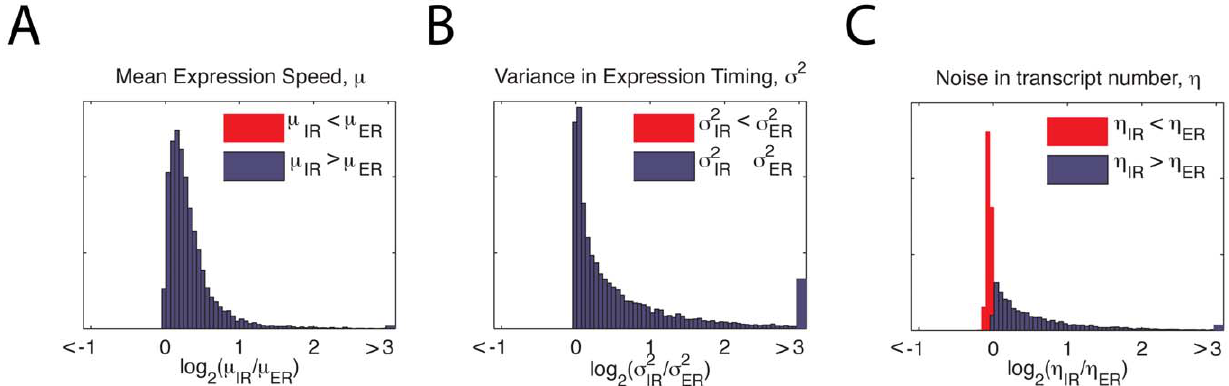
Figure 4. Model results. ( A ) Comparison of log ratios of mean expression speed for the IR/ER schemes for 10,000 uniformly sampled rates. For all jump rates, the log ratio is positive (red line), indicating the ER scheme is always faster. Extreme values that would be off the edge of the graph are collected into the outermost bins. ( B ) Variance in timing of expression. ( C ) log 2 ratio of noise in transcript number, measured by the squared coefficient of variation between cells of total mRNA counts N ( t ) up to time t : s 2